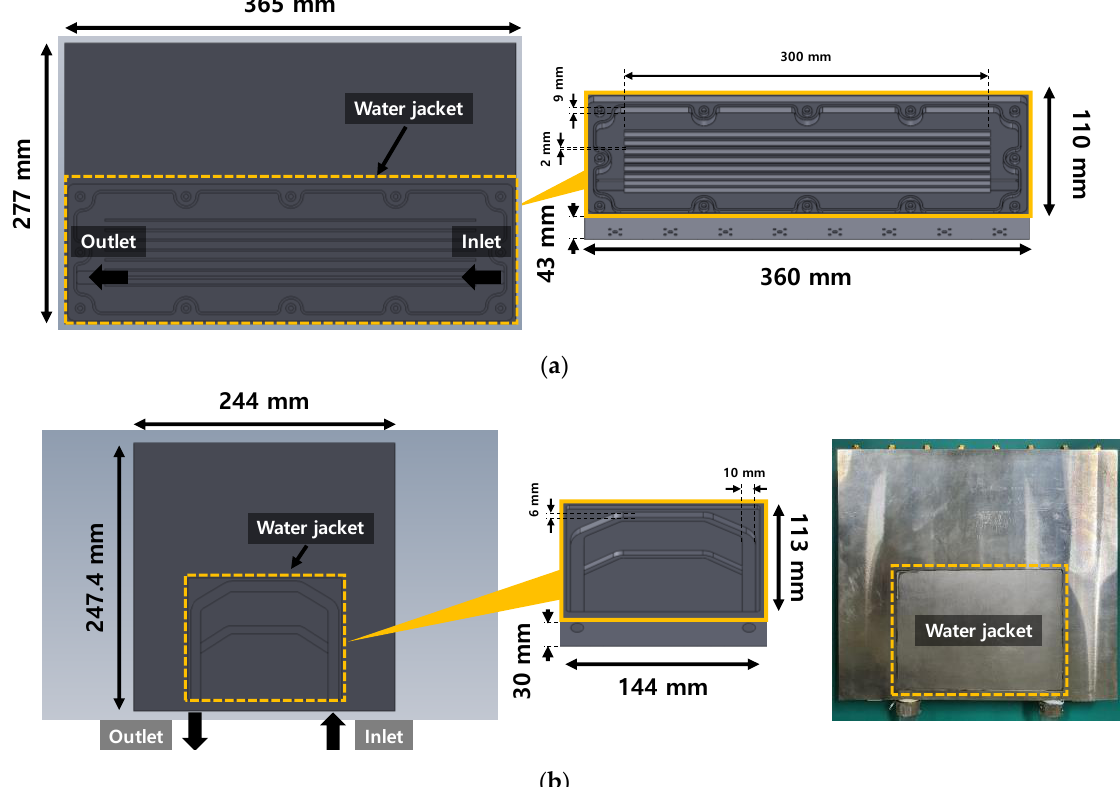
Figure 5. System-level packaging with liquid cooling: ( a ) a 3D model of the previous module; ( b ) a 3D model and photograph of the proposed module using brazing process.